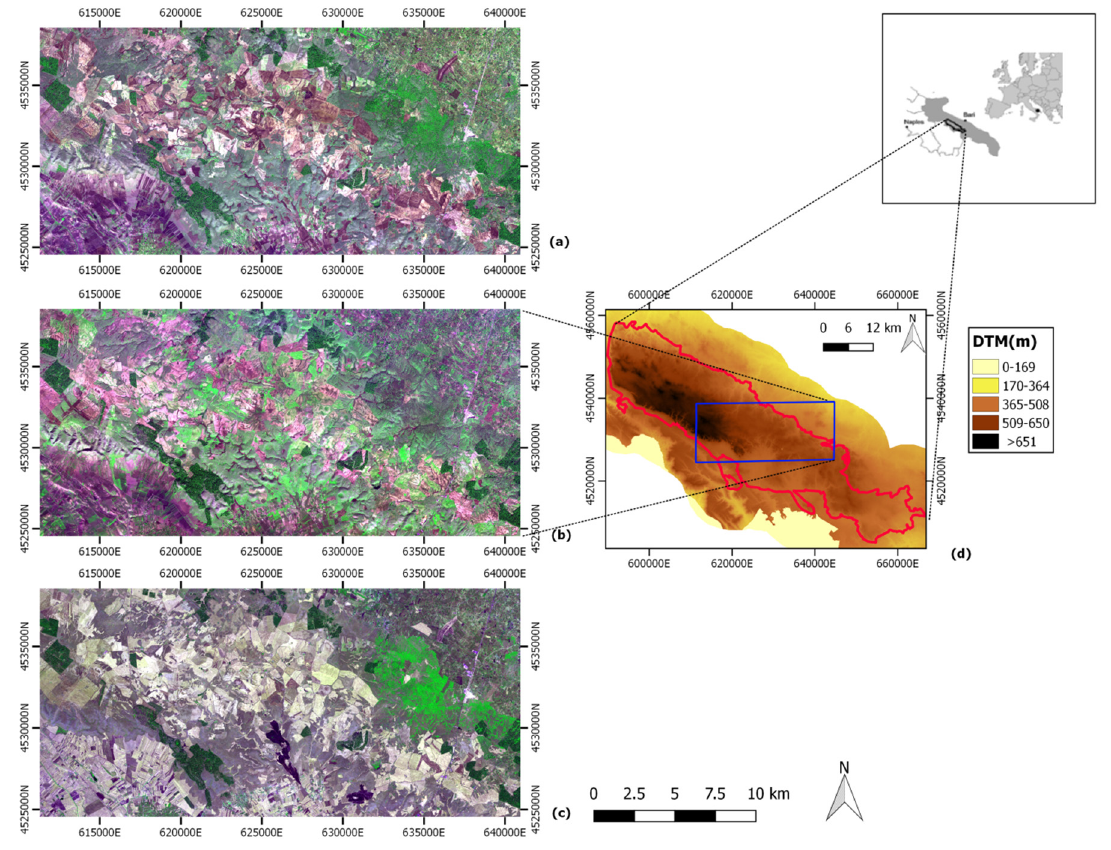
Figure 1. WorldView-2 (WV-2) input image, 2 m resolution, acquired on 5 October 2011 ( a ), on 22 January 2012 ( b ) and on 6 July 2012 ( c ). RGB (Red-Nir1-Blue) false color composition. Location and extension of “Murgia Alta” protected area in red line. The 500 km 2 analyzed area in blue line. Background image from OpenStreetMap ( d ).